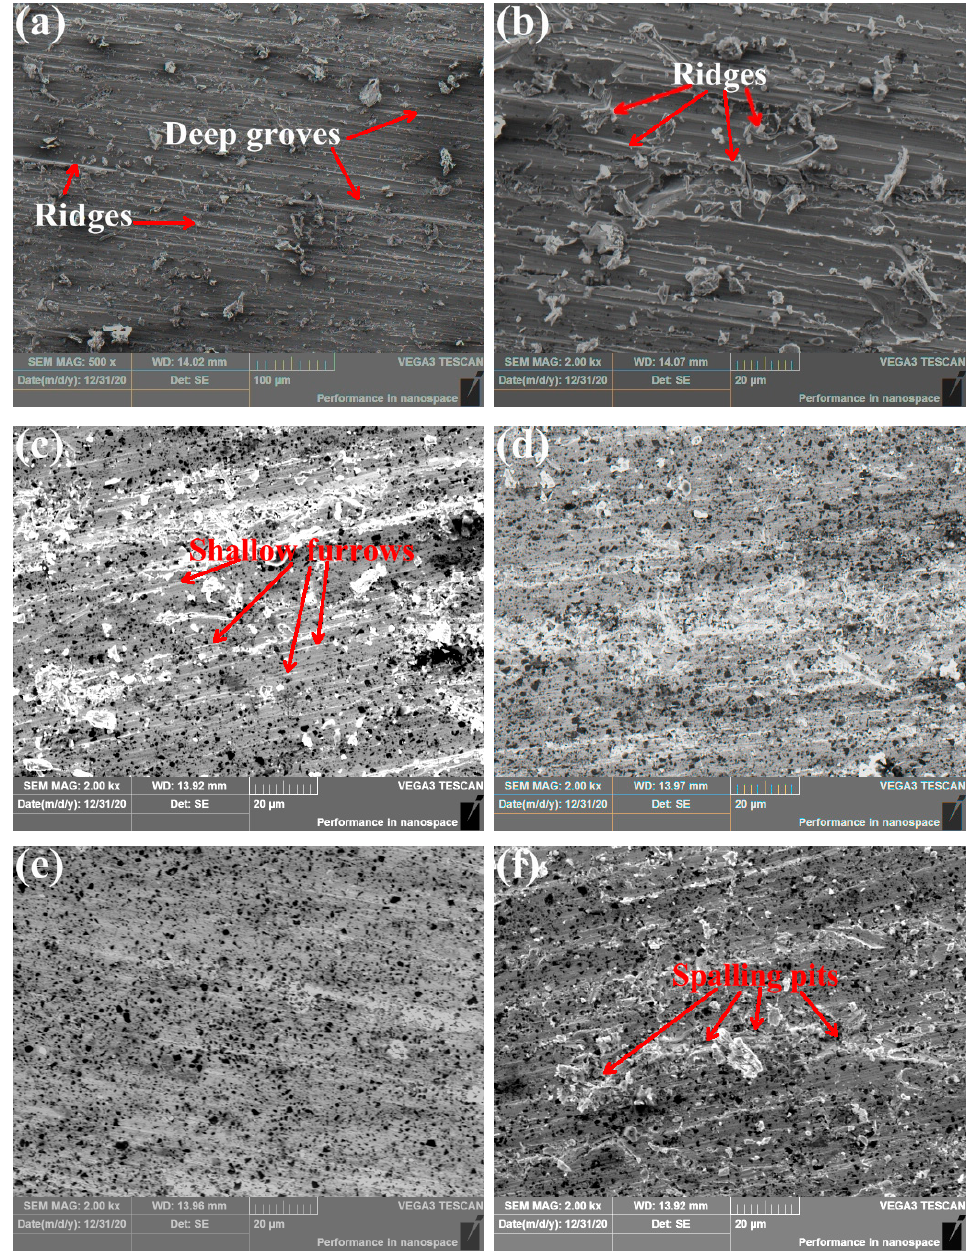
Figure 9. Worn B 4 C/Cu composite morphologies with different B 4 C contents: ( a ) pure Cu (low magnification); ( b ) pure Cu (high magnification); ( c ) Cu-5 wt.% B 4 C; ( d ) Cu-10wt.% B 4 C; ( e ) Cu-15 wt.% B 4 C; ( f ) Cu-20 wt.% B 4 C.